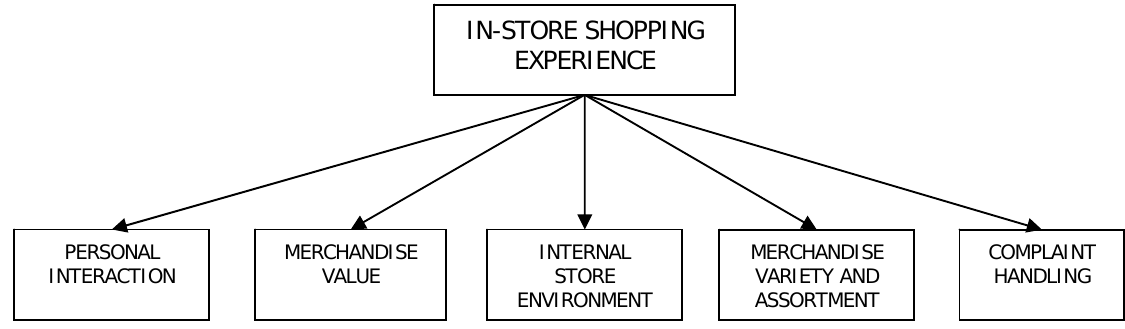
Figure 1: The structure of the in-store shopping experience